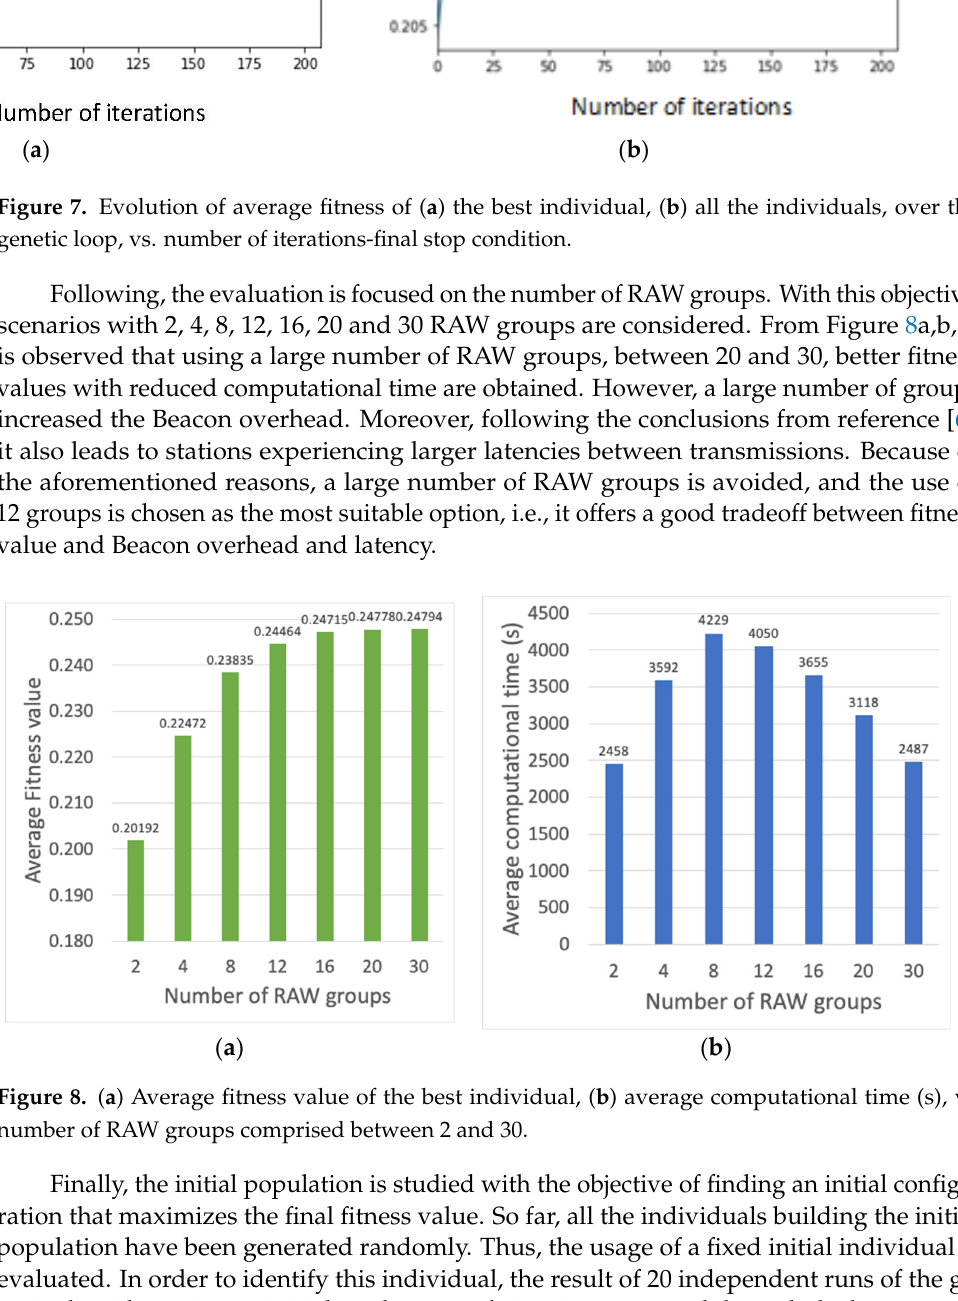
Figure 7. Evolution of average fitness of ( a ) the best individual, ( b ) all the individuals, over the genetic loop, vs. number of iterations ‐ final stop condition.